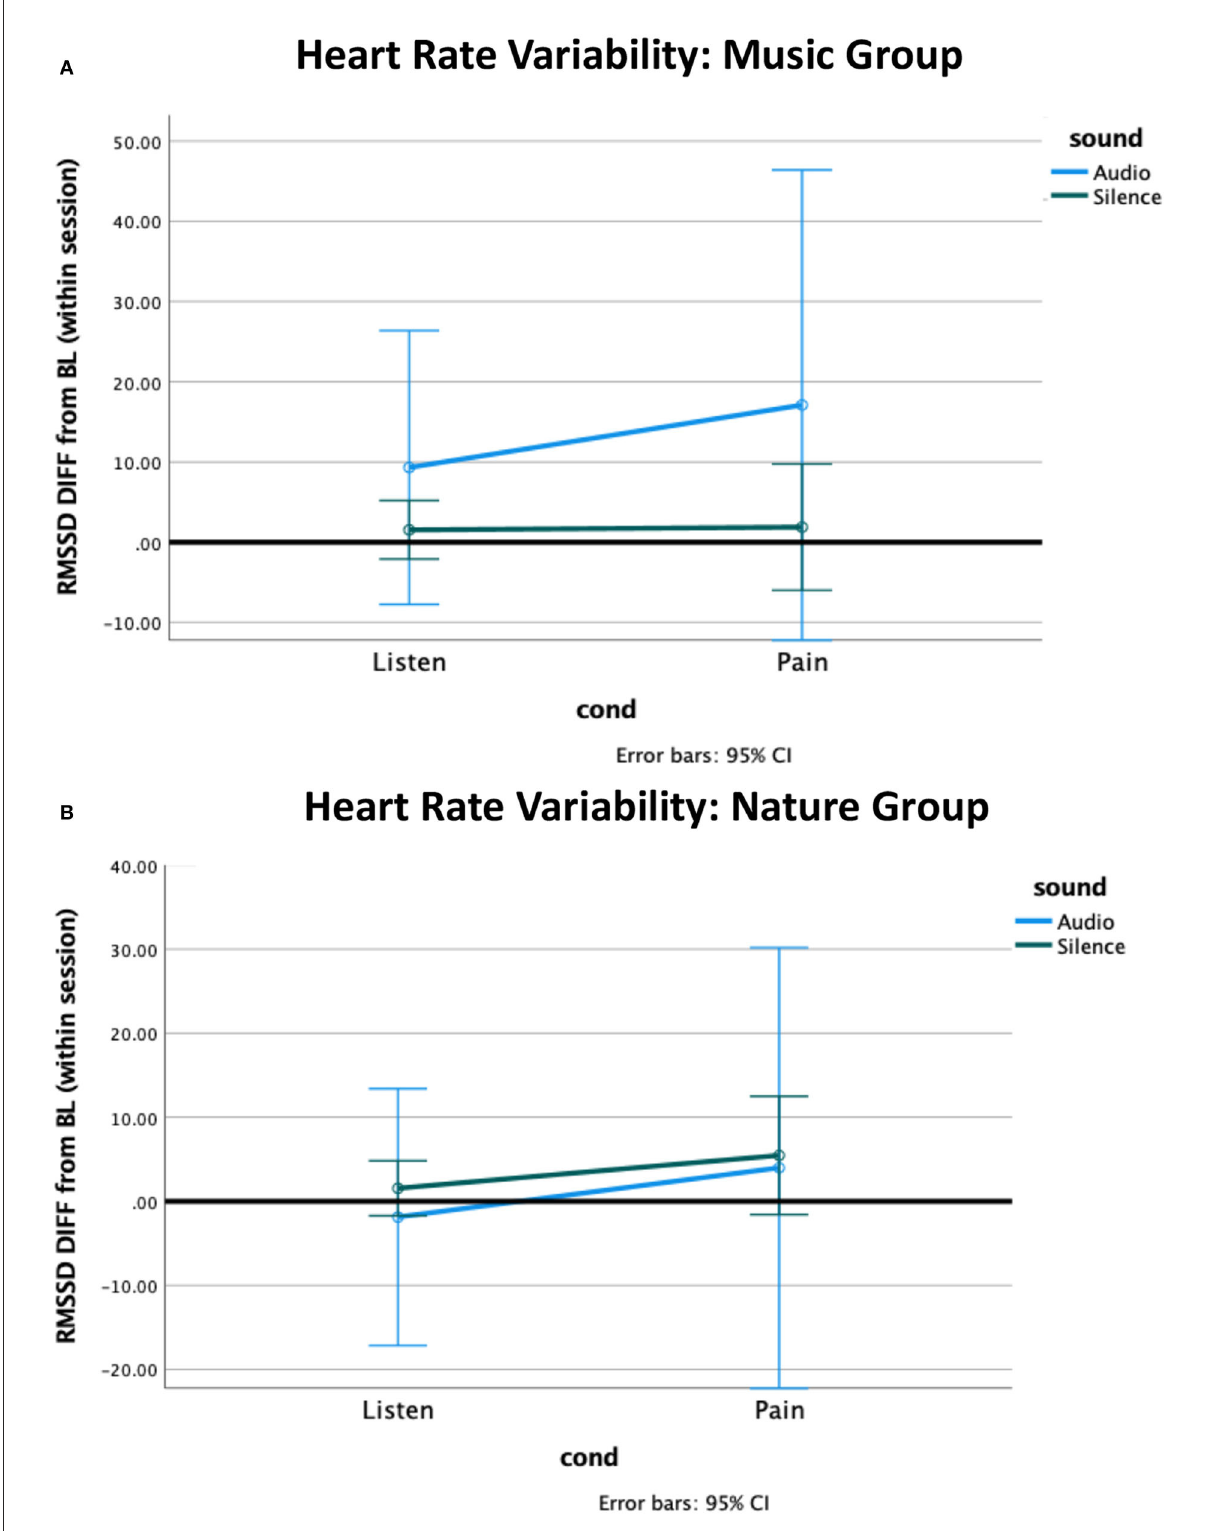
FIGURE3 Heart rate variability (HRV) difference from within-session baseline. (A) The HRV in the Music group increased from baseline to the listening condition, and further increased during pain, with no effect observed for silence. (B) The Nature group had marginally greater HRV during pain. The HRV during pain was associated with a high standard deviation in both